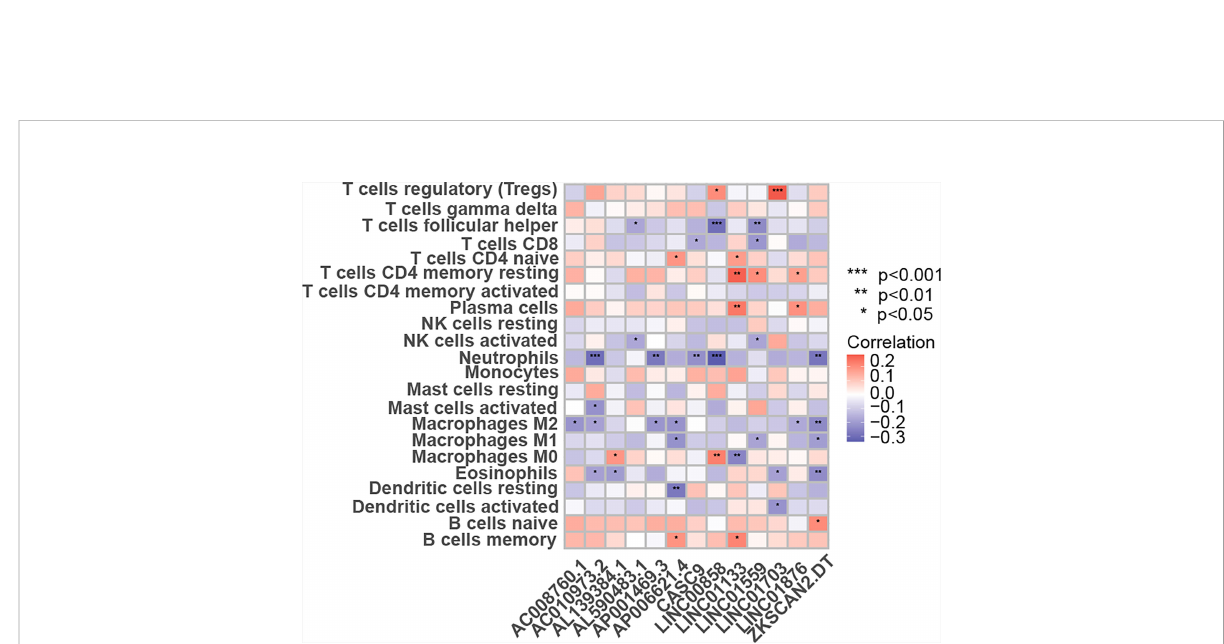
FIGURE 8 The link between the percentage of immune cells based on the CIBERSORT and the expression of 13 lncRNAs for creating the risk-scoring model. *p < 0.05, **p < 0.01, ***p <